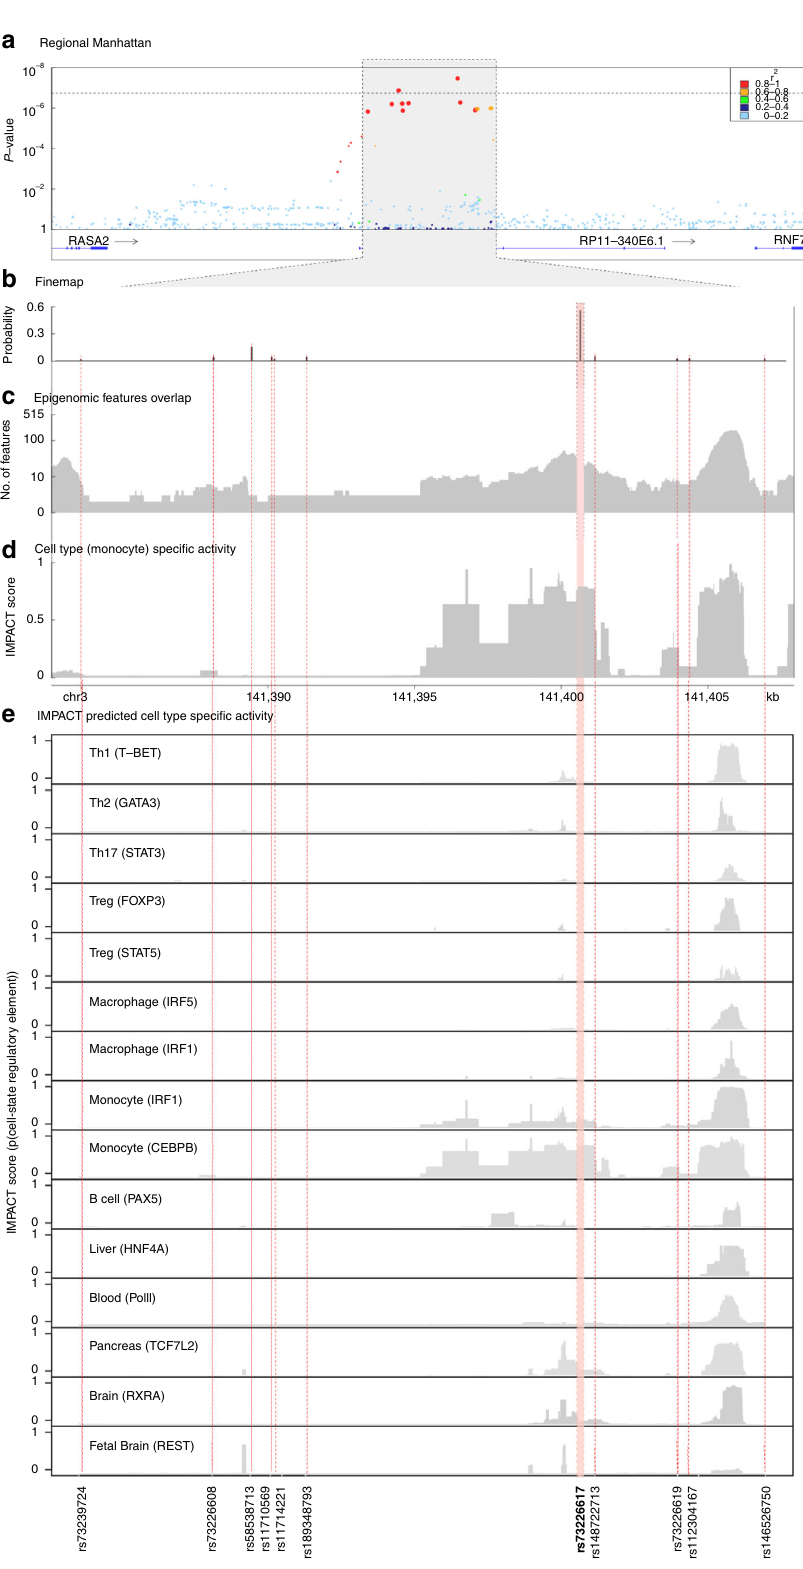
membrane proteins responsible for establishing and maintaining the electrochemical gradients of sodium and potassium ions across the plasma membrane through active transport against their osmotic gradients. A recent study demonstrated that the